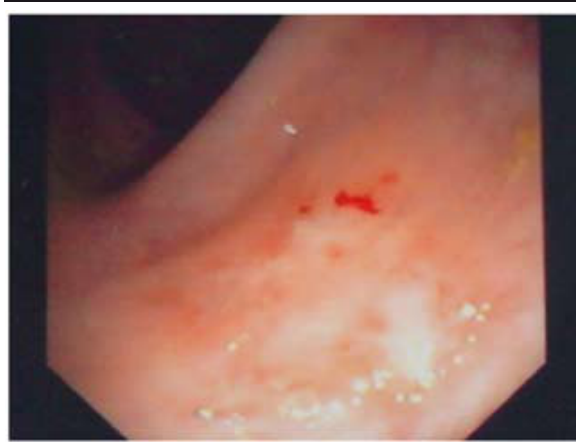
Figure 1. Rectal ulcer with fresh blood in the margin.